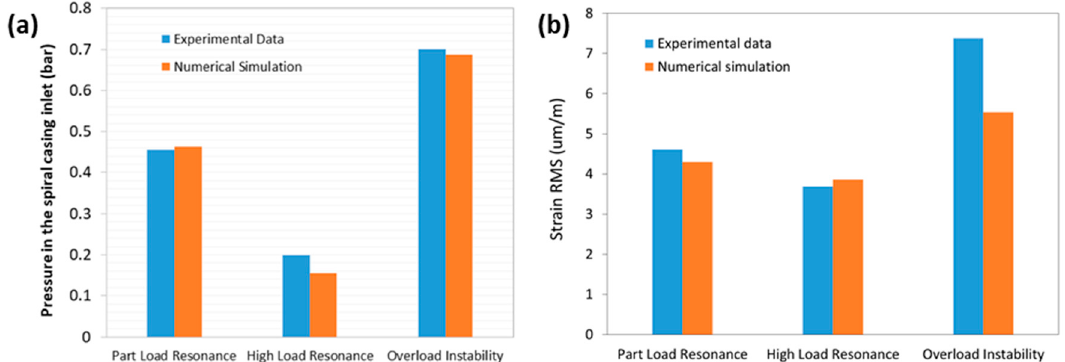
Figure 20. Comparison between experimental and simulation data for the pressure in the spiral casing inlet ( a ) and the torque fluctuation ( b ) for the three operating conditions tested.